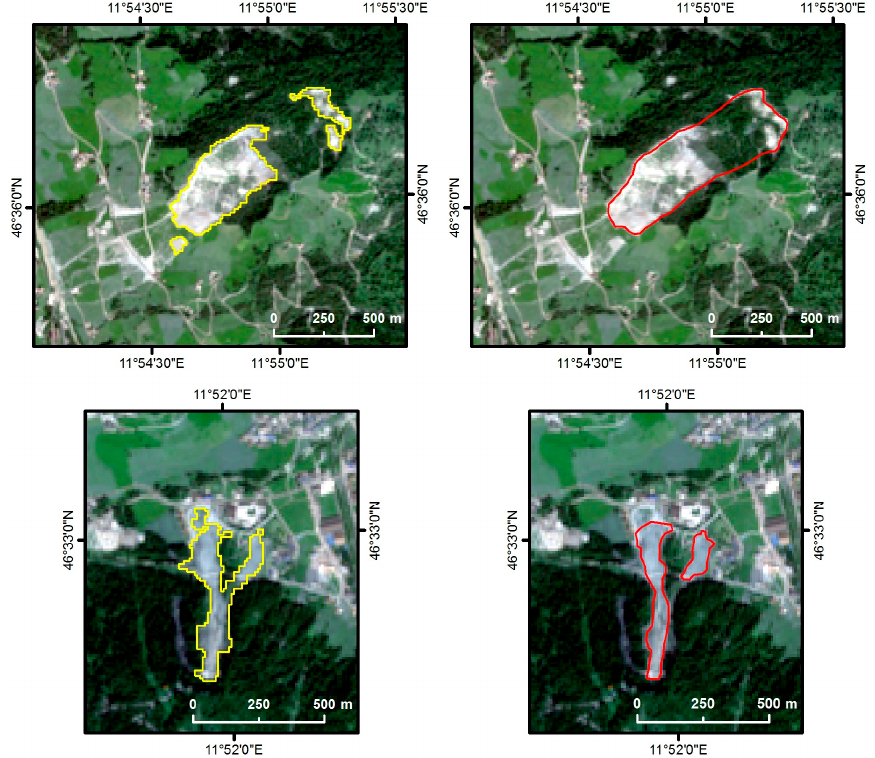
Figure 6. Semi-automatically mapped landslides using the object-based image analysis (OBIA) approach (in yellow; left ) and manually mapped landslides (in red; right ) for study areas V(a) ( top ) and V(b) ( below ) based on the Sentinel-2 image.